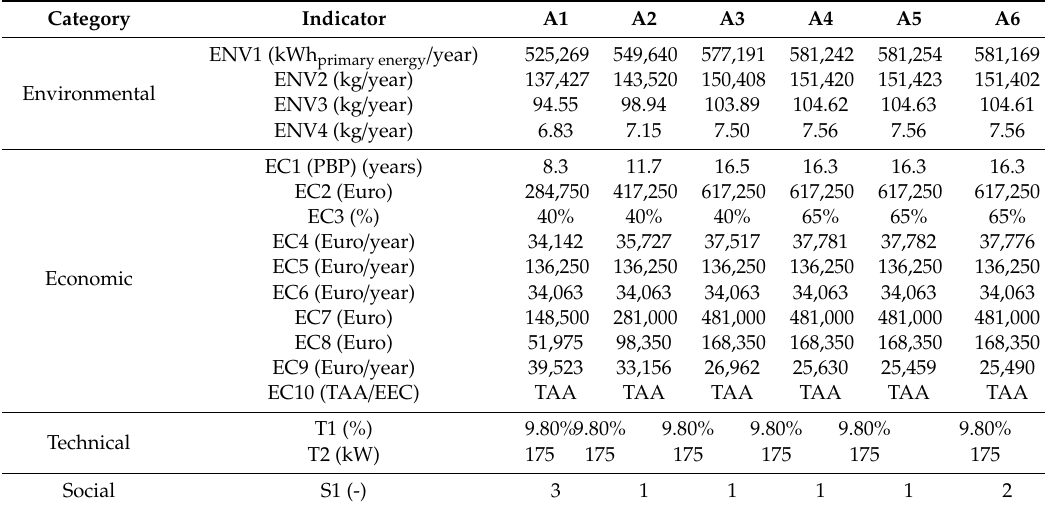
Table 13. Evaluation